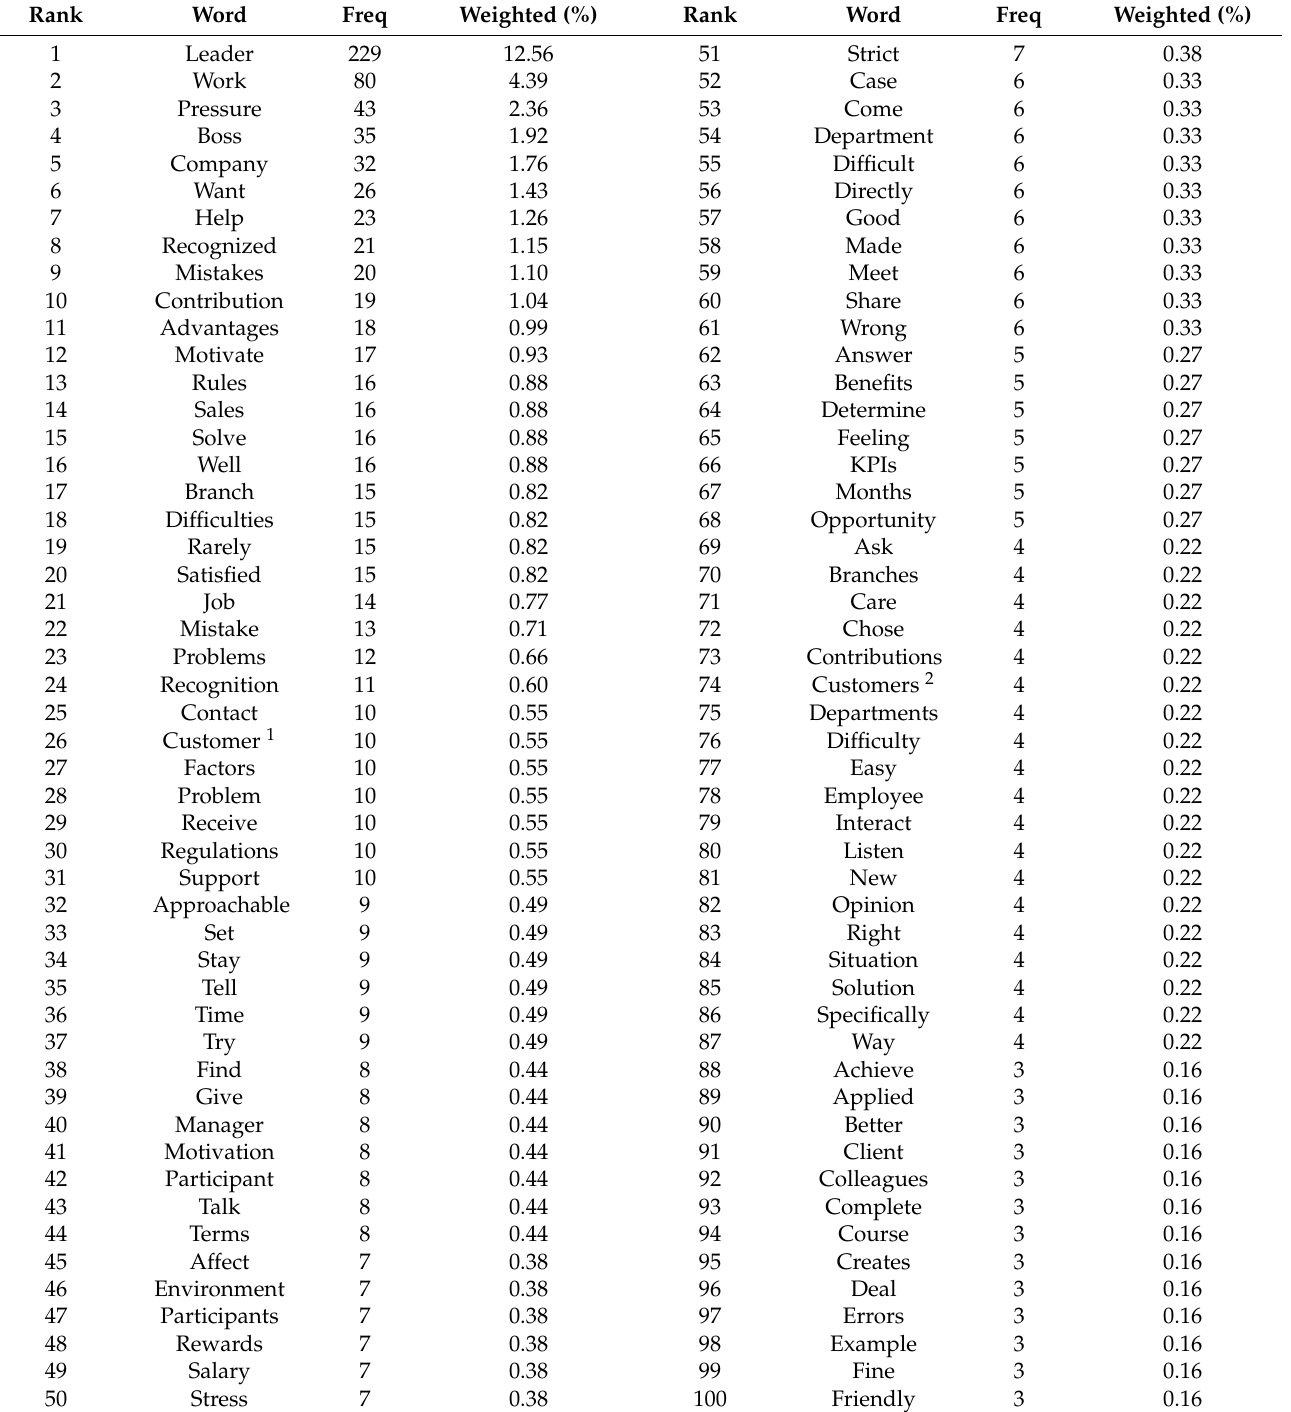
Table 2. Frequency of the 100 top